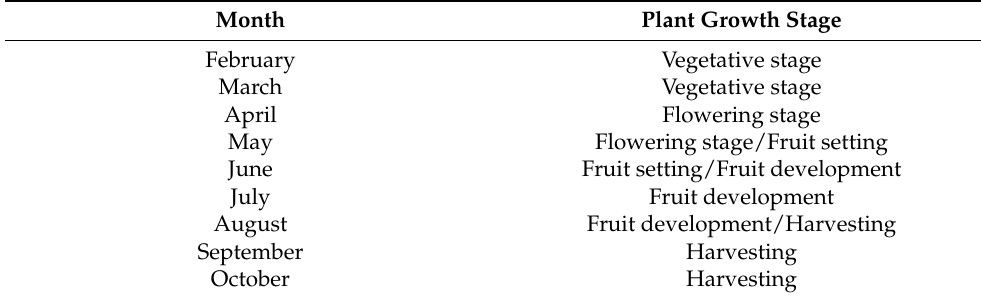
Table 2. Plants turn in different growth stages during the growing periods.